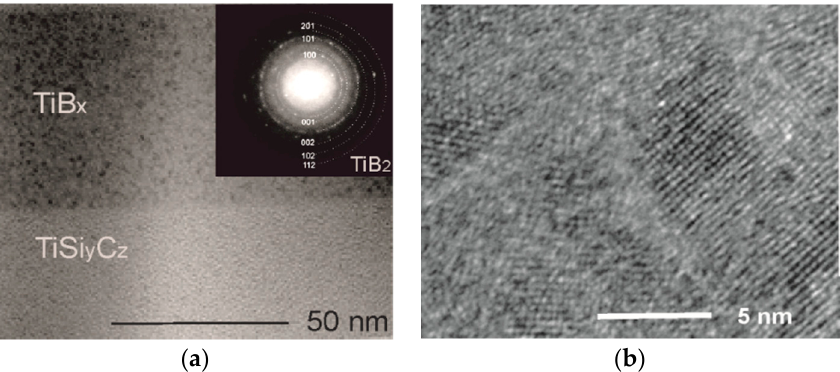
Figure 2. The microstructure of the annealed coating: ( a ) TEM image with inserted SAED pattern, taken from TiB x layer; ( b ) nanocrystallites in TiB x layer (HRTEM image taken from TiB x layer).